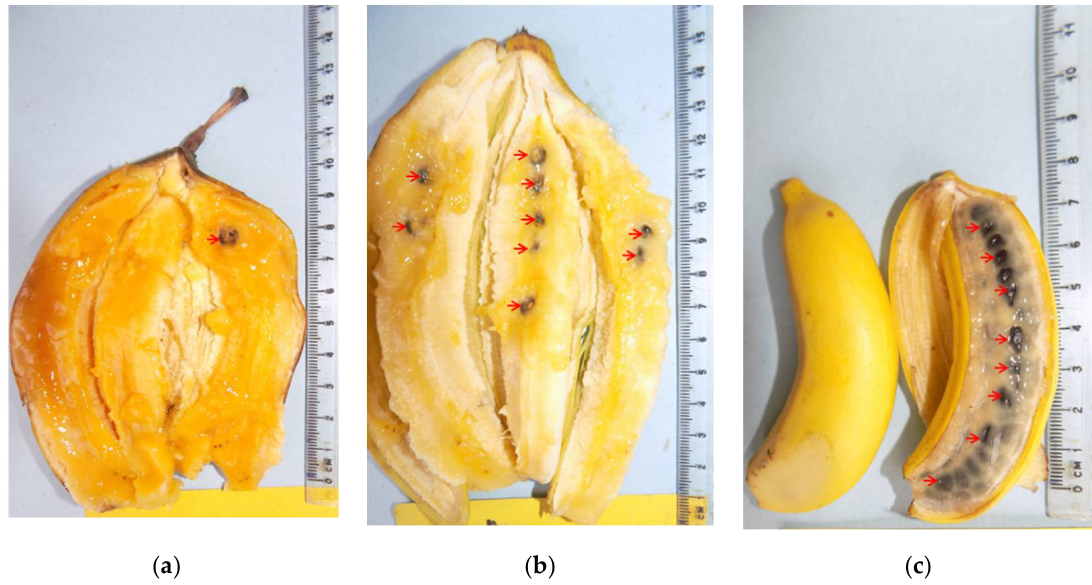
Figure 5. Seed set position denoted by red arrows in fruits as revealed after ripening among selected banana genotypes. ( a ) Single seed set in the distal end of “Enzirabahima” pollinated with “Calcutta 4”. ( b ) Multiple seed in the distal end of the fruit in the cultivar “Nshonowa” pollinated with “Calcutta 4”. ( c ) Small intact and peeled fruits of non-parthenocarpic open pollinated wild banana “Calcutta 4” with numerous evenly distributed seed. Table 3. Second order polynomial and R 2 values fitted for seed set per 100 fruits per hand. Bunch Size Cultivar (Hands)